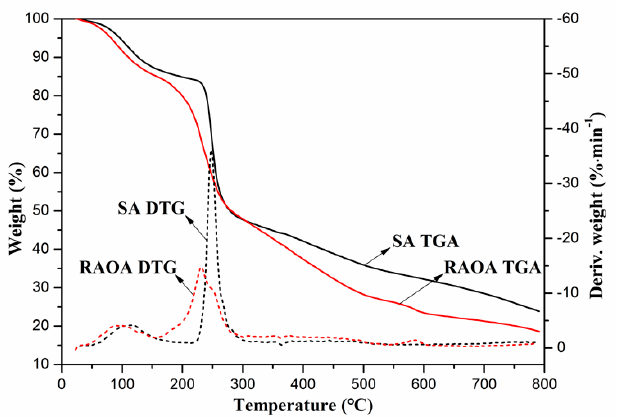
Figure 4. Thermograms of SA and RAOA.